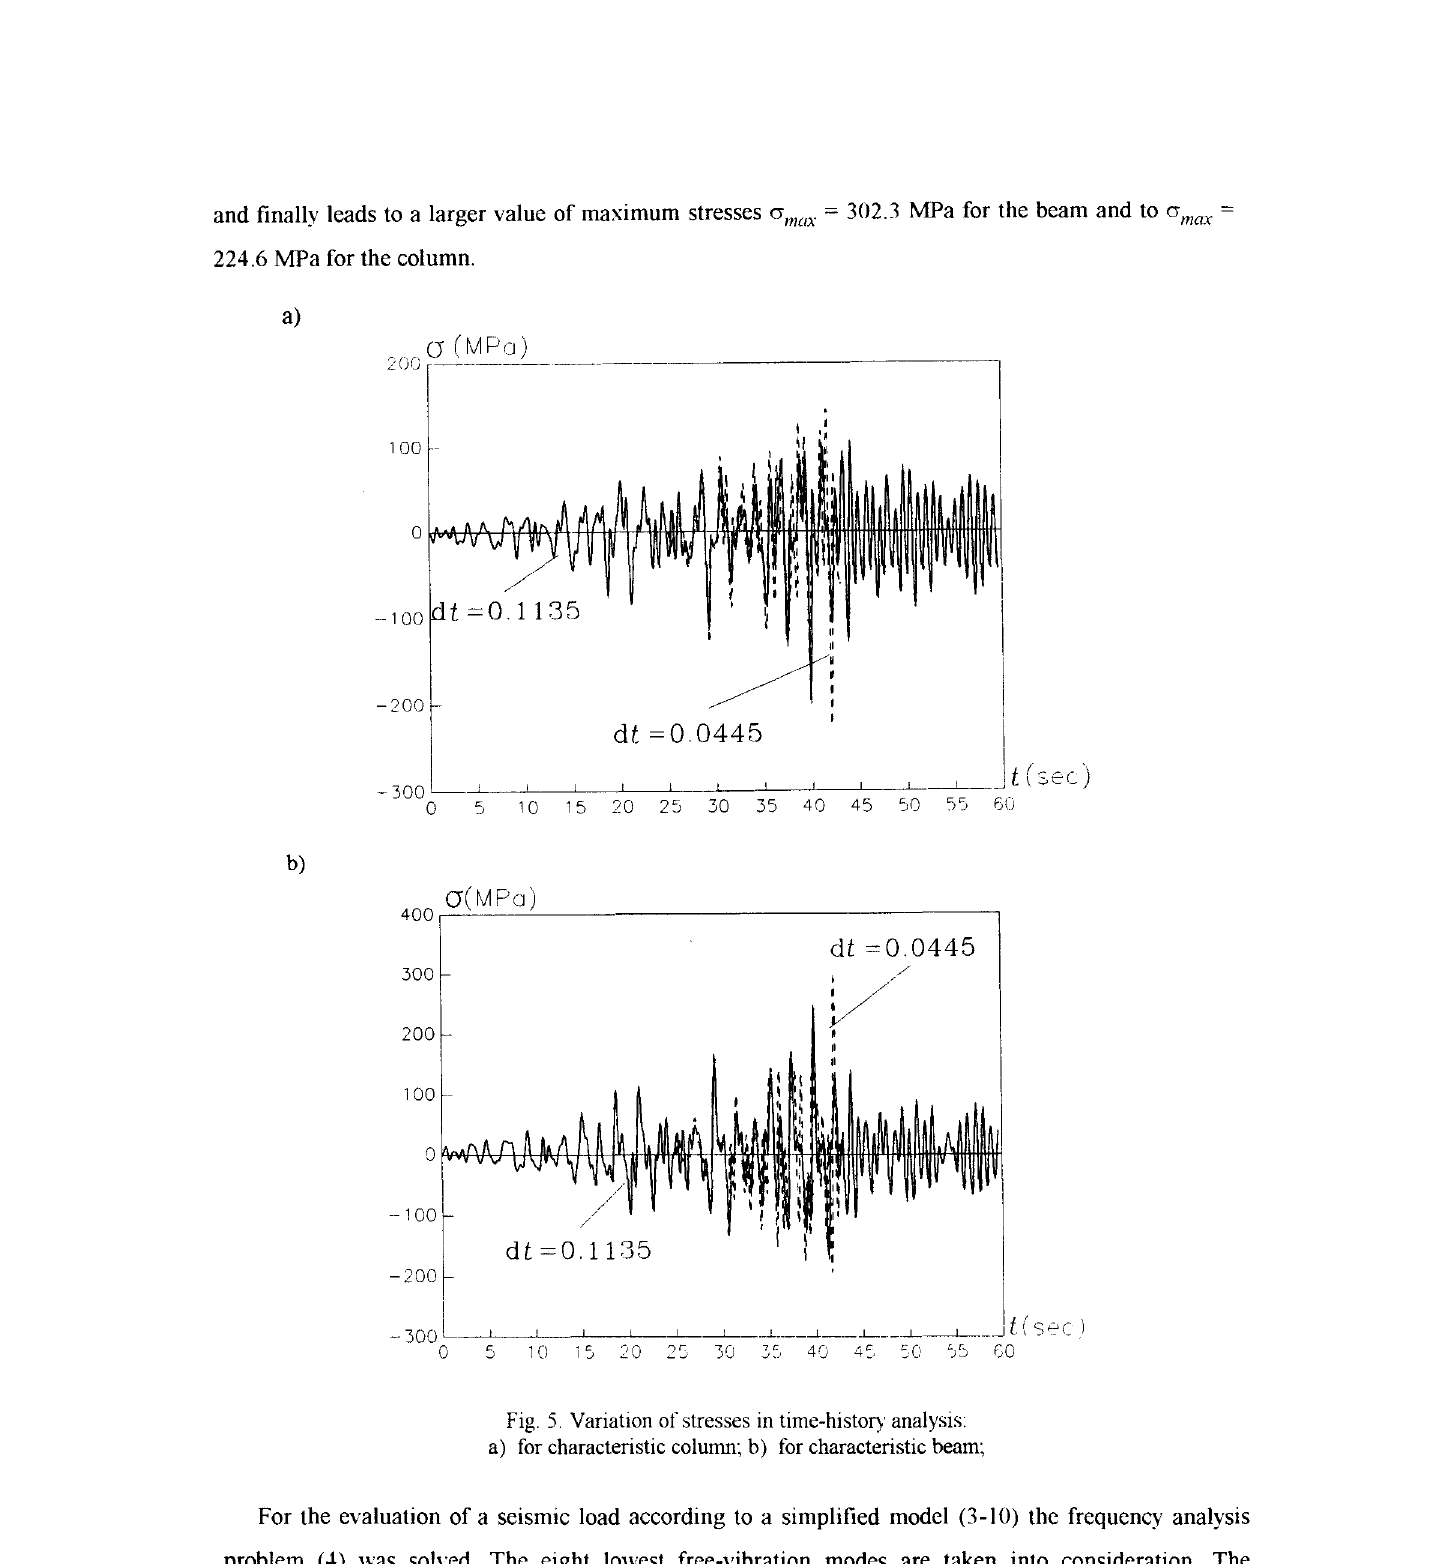
Fig. 5. Variation of stresses in time-history analysis: a) for characteristic column; b) for characteristic